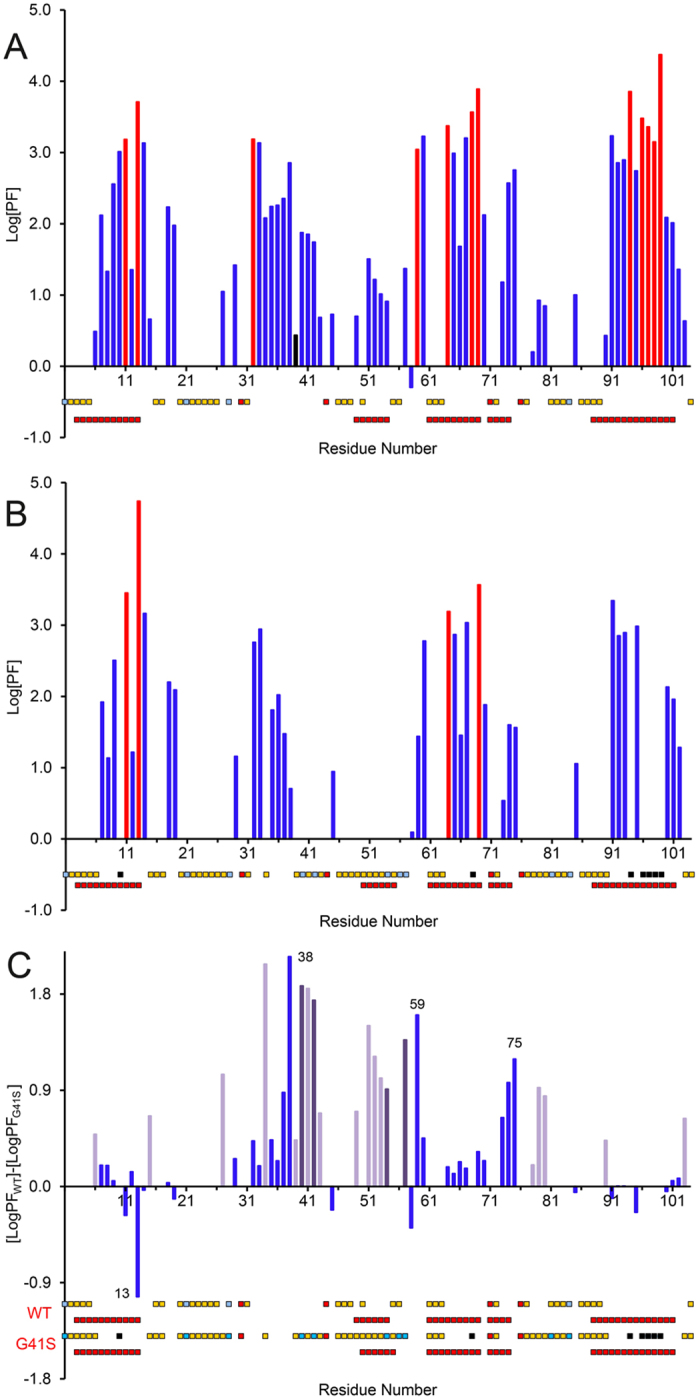
Backbone amide proton H/D exchange analysis of H-ferricyt and its G41S variant.PFs for WT (A) and the G41S variant (B) plotted against the residue number. For WT, 12 residues underwent fast-exchange (logPF ≤ 1), 16 medium (1 < logPF ≤ 2), 23 slow (2 < logPF) and 12 extremely slow-exchange (residual proton occupancy >80% after ~68 h, corresponding to exchange rates < 0.003 h−1, shown in red). For G41S, 4 residue underwent fast-exchange, 14 medium, 15 slow and 4 extremely slow-exchange (residual proton occupancy >80%, after ~72 h, corresponding to exchange rates < 0.003 h−1, shown in red). Secondary structure (α-helix) is indicated by the bottom red squares, while red squares above represent Pro residues. Unassigned and very fast-exchanging residues are indicated in light blue and yellow squares, respectively. Residues for which PFs could not be calculated due to the slowness of the exchange in the G41S variant are indicated with black squares (7 residues). (C) PF difference plot of [logPWT]-[logPG41S] shown in blue. Residues that are fully exchanged in G41S have the PFs observed for WT displayed (light purple). Residues that are unassigned only for the G41S variant have the PFs observed for WT displayed (dark purple).